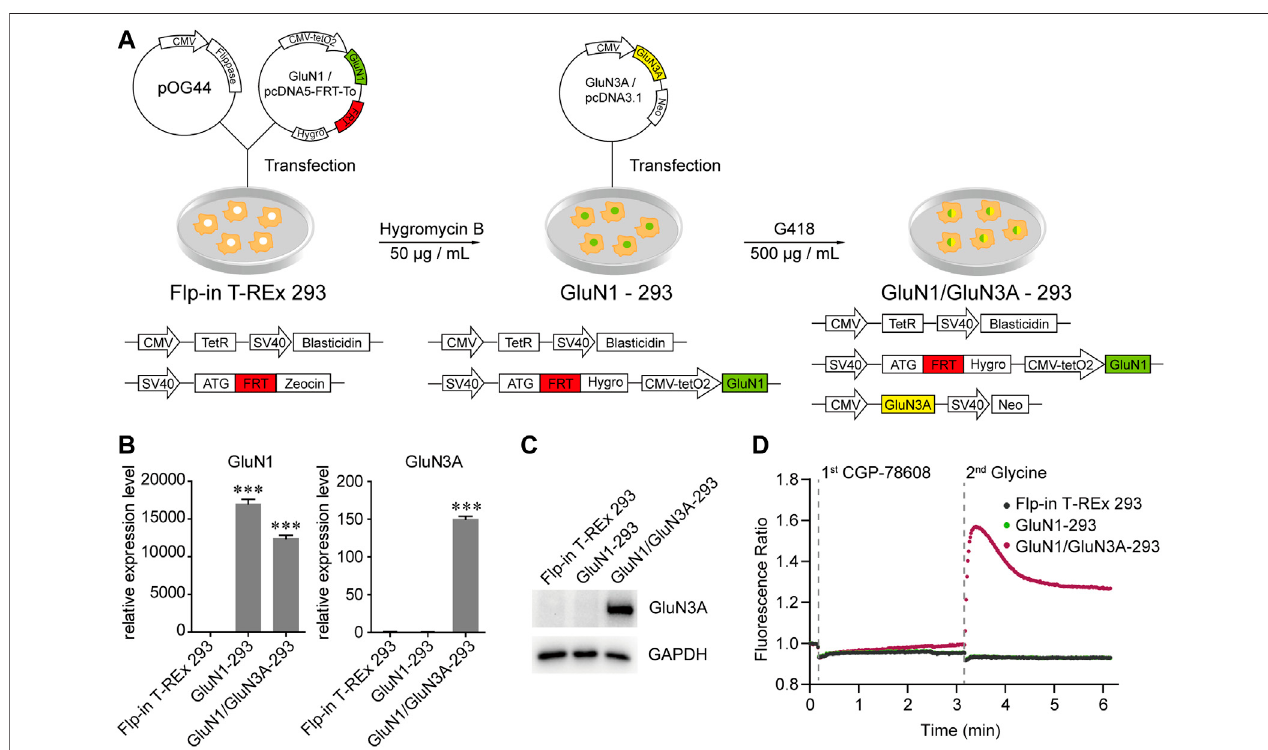
FIGURE 1 | Generation and functional veri fi cation of GluN1/GluN3A Flp-in T-REx 293 stable cell lines. (A) Schematic graph showing the generation of GluN1/ GluN3AFlp-inT-REx 293stable celllines. (B and C) Expression levelsofGluN1and GluN3AintheGluN1/GluN3Astablecelllinesveri fi edbyqRT-PCR (B) and Western Blot (C) . (D) GluN1/GluN3A stable cell lines formed functional ion channels. When the channels were activated by CGP-78608 and glycine, Ca 2+ fl owed into cells and boundtoFluo-4,resultingina fl uorescencesignaldetectedbyaFDSS/ μ Cellplatform.Thebasal fl uorescencevaluewasautomaticallynormalizedto1intheFDSS/ μ Cellplatform, sothereal-time fl uorescence response wasdisplayed asa fl uorescenceratio.Signi fi cancewastested usingone-wayANOVA; p p < 0.05, pp p < 0.01and ppp p <